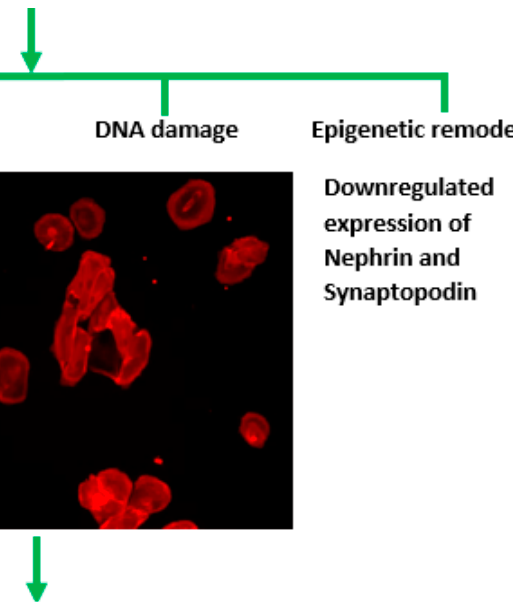
Figure S5: Dynamic changes in the morphology of human urine derived podocytes post treatment with Angiotensin II (ANGII) after 6 h and 24 h and is rescued by Losartan; Figure S6: Kegg-pathway Renin-Angiotensin system; Figure S7: Secretome membranes and analysis of podocytes with and without 6 h and 24 h of Angiotensin II treatment; Figure S8: Full size Western blot figures for A = GAPDH, B = NPHS1 and C = SYNPO; Figure S9: Full size Western blot figures for A = GAPDH, B = NPHS1 and C = SYNPO; Figure S10: Albumin uptake assay in UM51 podocytes; Figure S11: Principal component analysis of podocytes UM48 and UM51 with and without 6 h and 24 h of ANGII Table S4: UdRPC vs podocyte; Table S5: Podocyte up; Table S6: Podocyte down; Table S7: Podocyte vs. 24 h angII; Table S8: 24 h angII up; Table S9: 24 h angII down; Table S10: differentially expressed genes podocyte and udrpcs; Table S11: differentially expressed genes podocytes and podocytes treated with